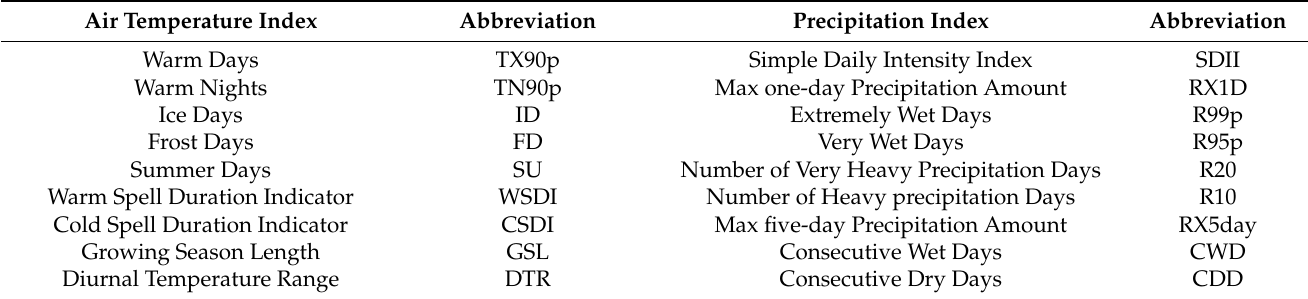
Table 2. Extreme temperature and precipitation indicators.